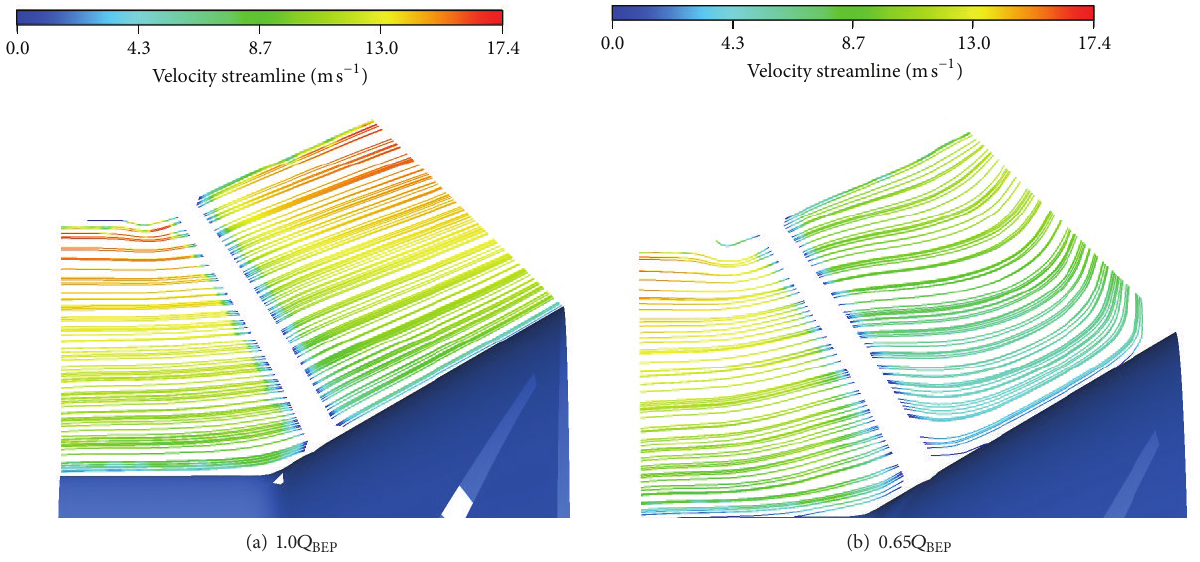
Figure 15: Velocity streamlines at the meridional section of impeller the passage without diffuser.